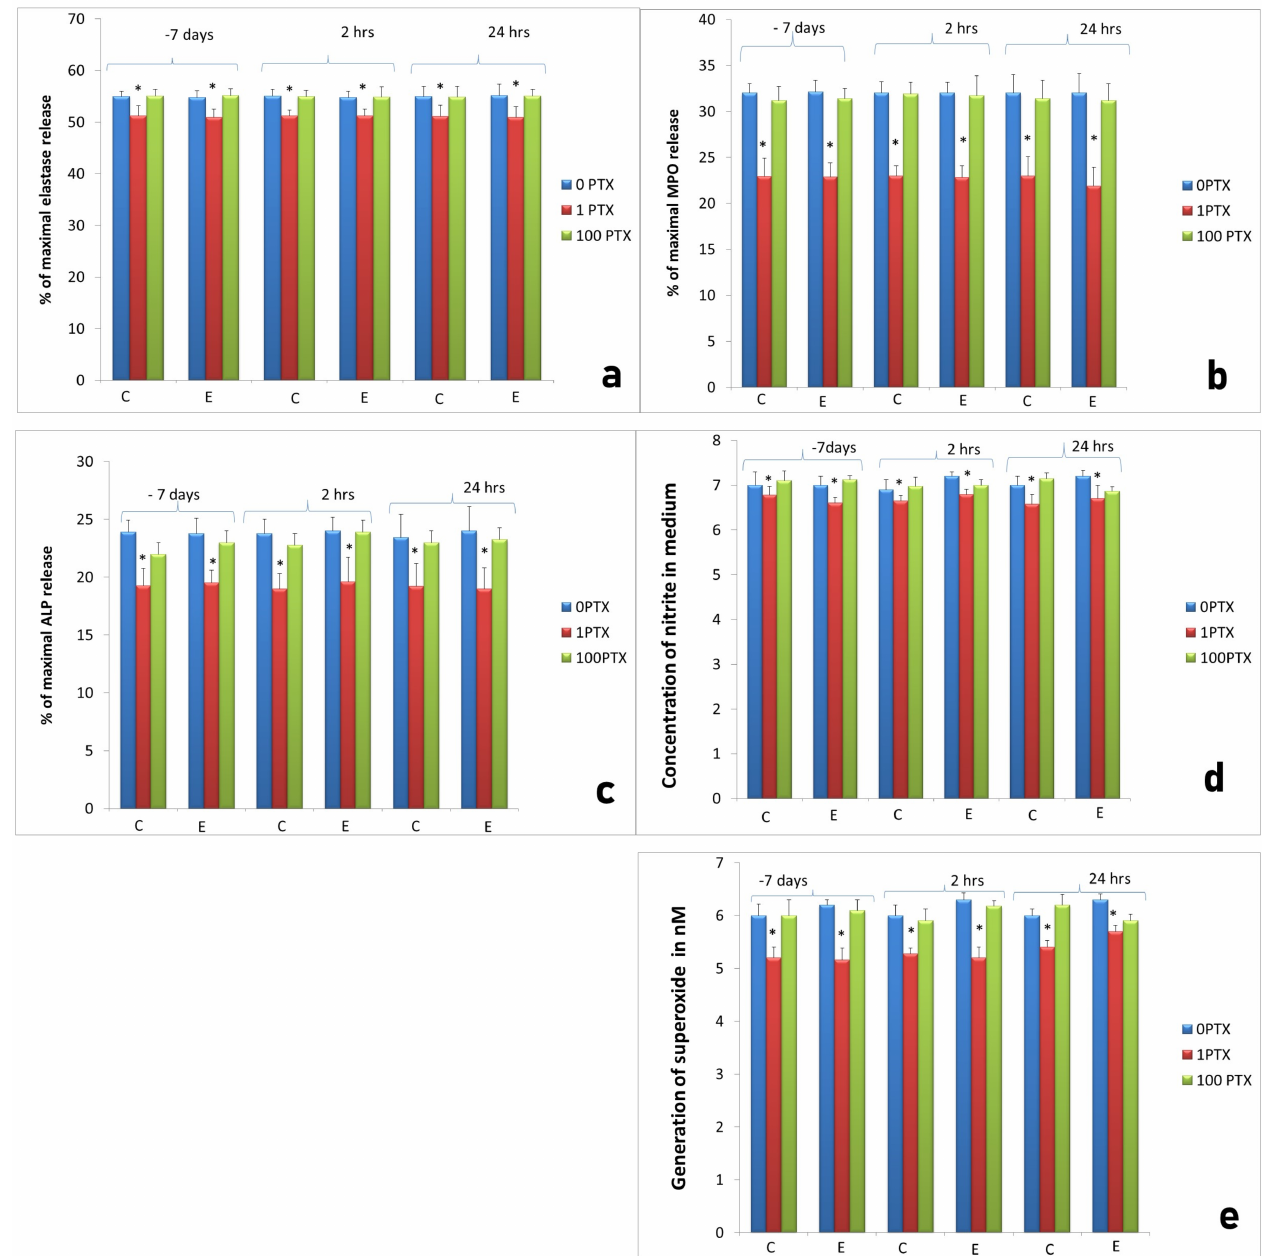
Figure 2. Activity of neutrophils isolated 7 days before, 2 h and 24 h after implantation (experimental: 8 sheep) compared to control groups of neutrophils isolated at the same time points from animals from control groups (control: 4 sheep). C: control group, E: experimental group. The response to implantation and treatment with two concentrations of PTX (1 and 100 µ g/mL); ( a ) elastase release from neutrophils, ( b ) MPO release, ( c ) ALP release, ( d ) NO generation, ( e ) superoxide generation in the inflammatory phase of the repair process. Data present mean values ± SE of at least three replicates for each bar. * p < 0.05 compared to cultures of neutrophils without stimulation (0 µ g/mL) at the same time